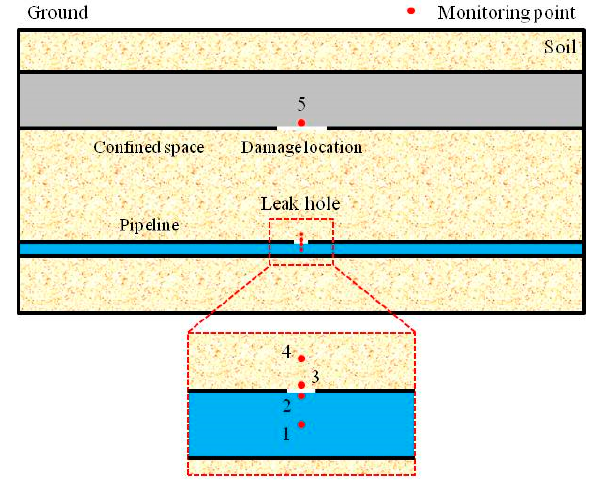
Figure 2. Schematic diagram of spatial location of monitoring points.